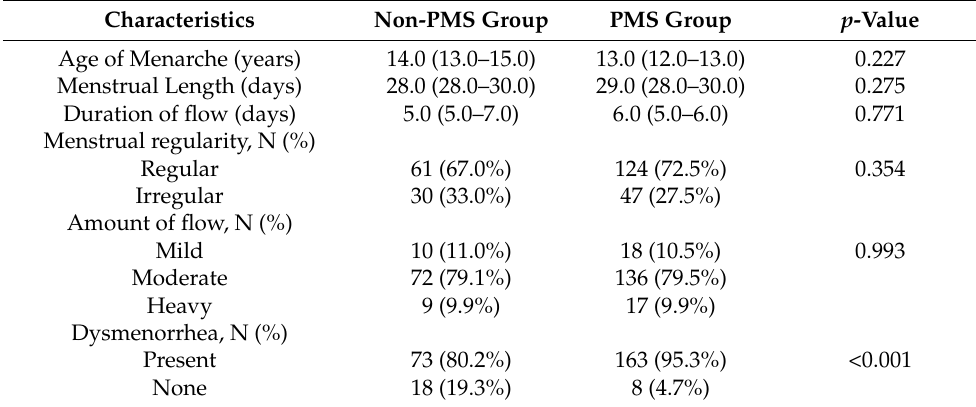
Table 2. Menstrual characteristics of the study participants by PMS